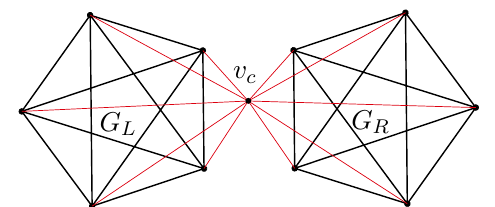
FIG. 6. The vertex barbell graph B 2 n , for n = 5, consisting of two complete graphs connected through an additional vertex. We have λ( G ) ≤ 2 / n by Lemma III.6.